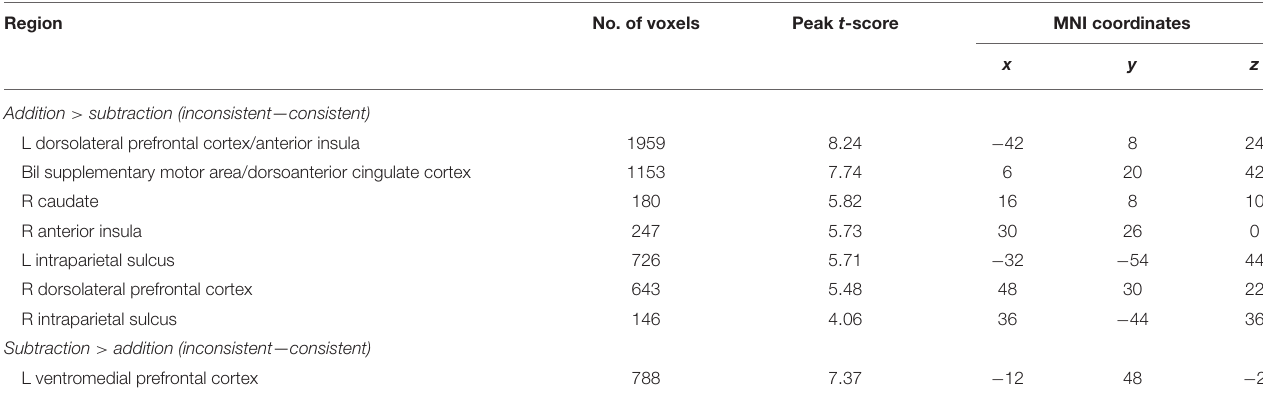
TABLE 2 | Brain regions that showed the interaction of consistency by